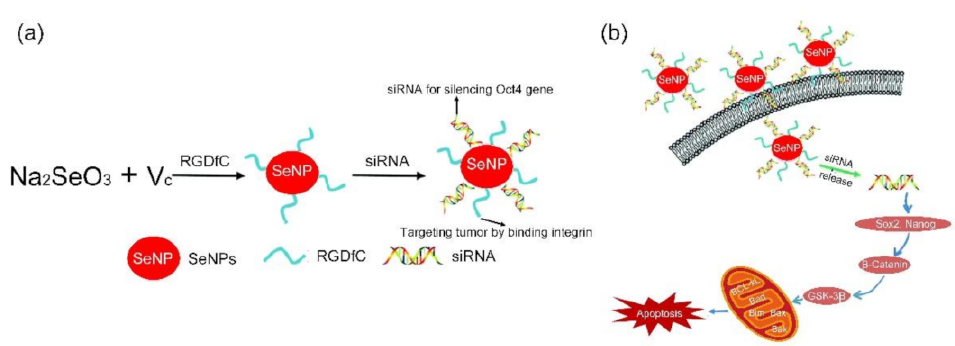
Figure 10. ( a ) Schematic representation of the formation of RGDfC-SeNPs/siRNA, and ( b ) the main signaling pathway of apoptosis induced by RGDfC-SeNPs/siRNA. The SeNPs were synthesized through reduction of Na 2 SeO 3 by ascorbic acid (Vc), which were functionalized by the cancer- targeting ligand, RGDfC peptide. The siRNA was then loaded on the surface of RGDfC-SeNPs to prepare RGDfC-SeNPs/siRNA. The RGDfC-SeNPs/siRNA can induce cell apoptosis by regulating the Wnt/ β -catenin signaling and activation of its downstream target gene (Adapted from Xia et al. 2017 [239], Copyright 2017 The Royal Society of Chemistry and reproduced with